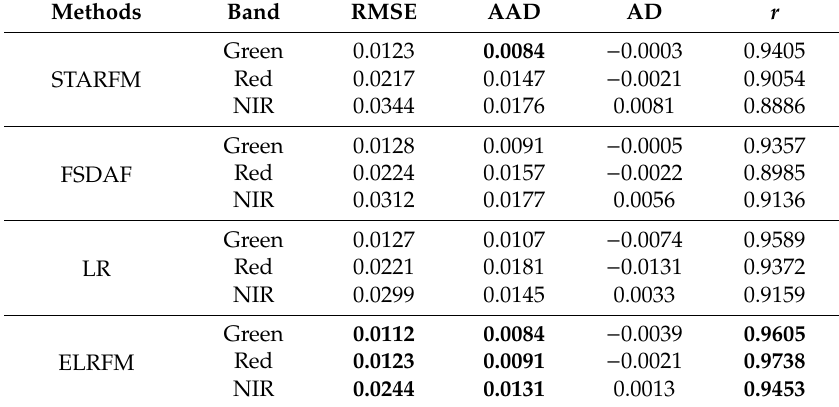
Table 1. Quantitative assessment results of the four data fusion methods. Root mean square